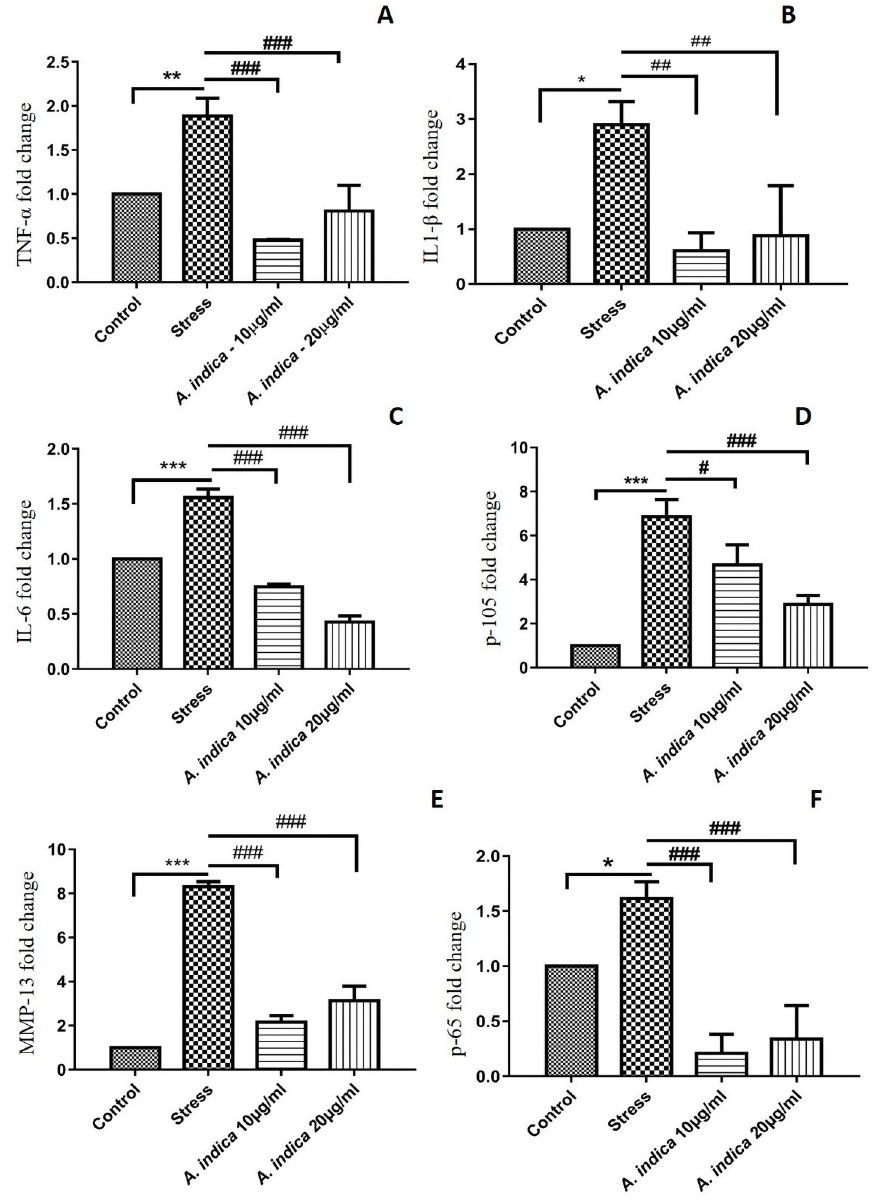
Fig 5. A . indica extract downregulated inflammatory and NF- κ B associated markers. (A) TNF α (MIA-10 μ M: 1.884510 ± 0.2028108, A . indica 10 μ g/ml 0.4779985 ± 0.007028175, A . indica 20 μ g/ml 0.8084317 ± 0.2906602), (B) IL- 1 β (MIA-10 μ M: 2.899046 ± 0.4191191, A . indica 10 μ g/ml: 0.6099128 ± 0.3266602, A . indica 20 μ g/ml: 0.8838717 ± 0.9084732), (C) IL-6 (MIA-10 μ M: 1.556122 ± 0.07970555, A . indica 10 μ g/ml: 0.7459561 ± 0.0240984, A . indica 20 μ g/ml: 0.4277192 ± 0.05663558), (D) NF- κ B p105(MIA-10 μ M: 6.866518 ± 0.7724251, A . indica 10 μ g/ml 4.671283 ± 0.9099906, A . indica 20 μ g/ml 2.872436 ± 0.4069114), (E) MMP-13(MIA-10 μ M: 8.303460 ± 0.2344566, A . indica 10 μ g/ml: 2.157991 ± 0.2970057, A . indica 20 μ g/ml: 3.130929 ± 0.6579115) and (F) NF- κ B p65 (MIA-10 μ M: 1.614739 ± 0.1505901, A . indica 10 μ g/ml 0.2085242 ± 0.1716187, A . indica 20 μ g/ml: 0.3398924 ± 0.3039037) mRNA expression levels were determined by qPCR. Values are statistically significant at p � < 0.05, p �� < 0.01, p ��� < 0.001compared with the control group while p# < 0.05, p## < 0.01, p### < 0.001 compared with stress group. The experiment was carried out in triplicates (n =